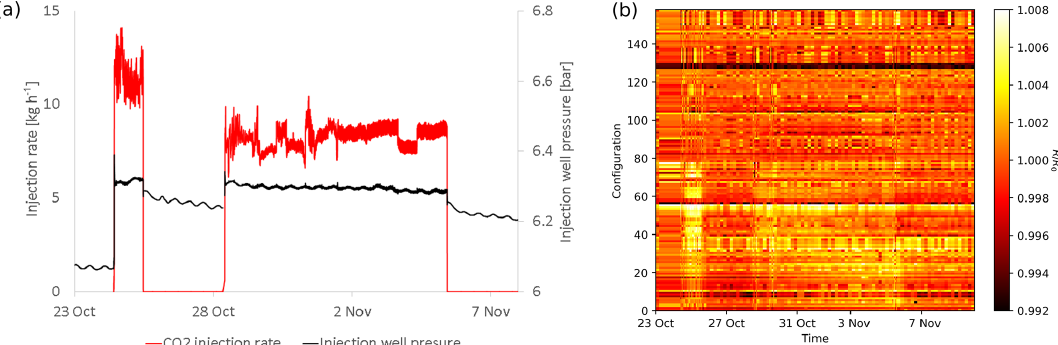
Figure 6. CO 2 injection rate during the field experiment. Approximately 1.7t of CO 2 have been injected. (b) Ratio of measured apparent resistivity between baseline- and subsequent measurements during the CO 2 injection. Shown are 168 geometry optimized AB–MN configu- rations measured on the between wells M3 and M4 (NS